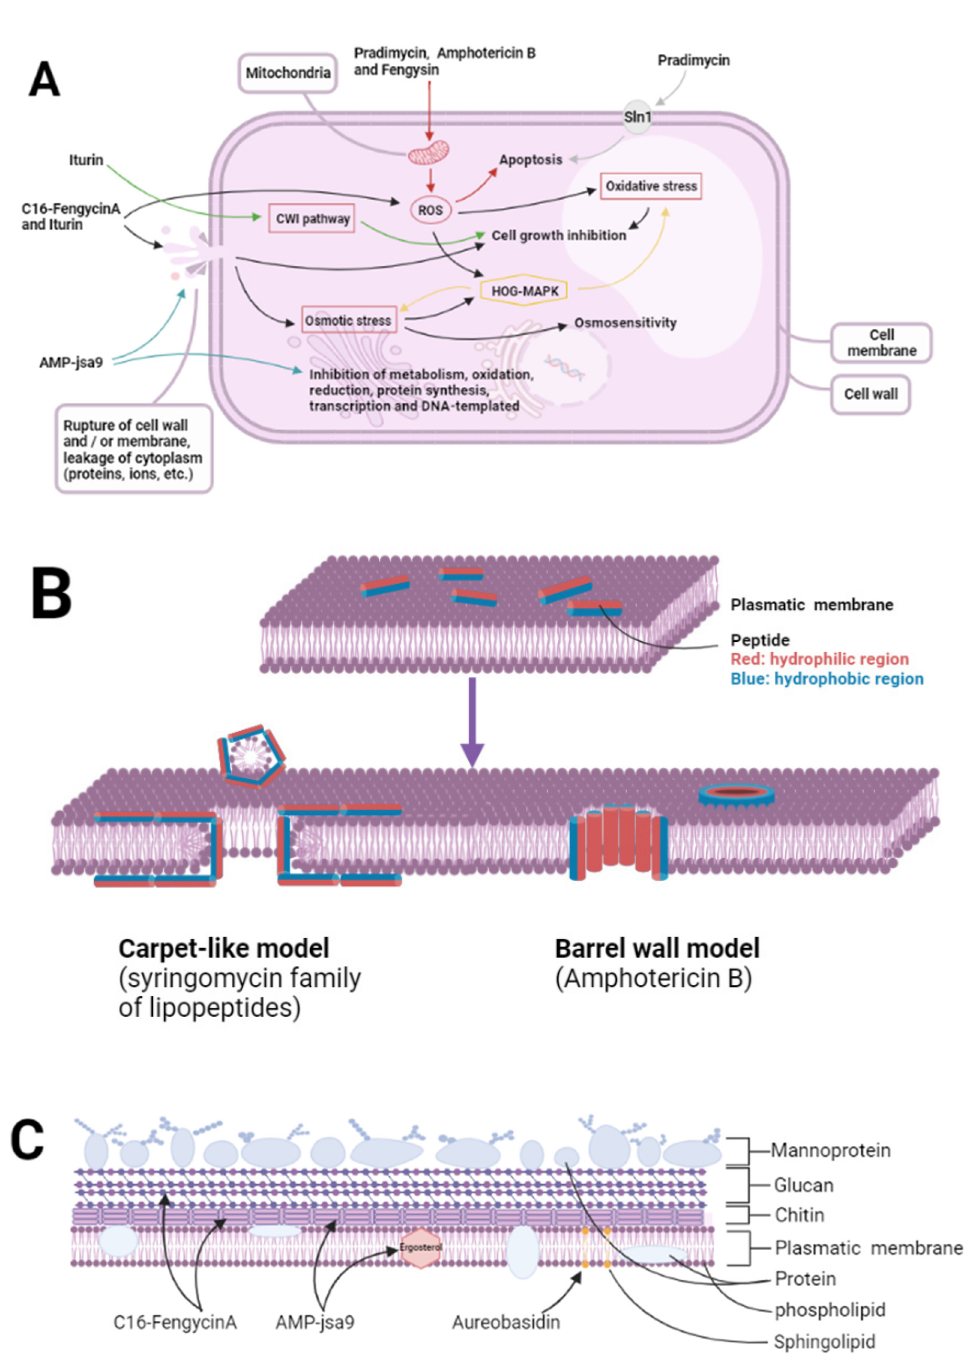
Figure 1. Action pathways and mechanisms of action of some antifungal peptides. ( A ) the mechanism of some antifungal peptides; ( B ) two models of destruction of cell membrane by mi-crobial antifungal peptides; ( C ) the main membrane structure of pathogenic fungi affected by antimicrobial